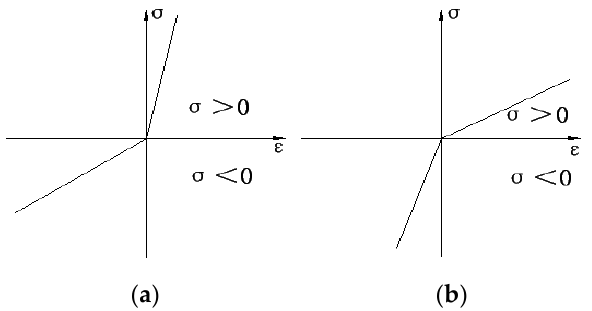
Figure 1. Bimodular materials model proposed by Ambartsumyan. ( a ) E + > E − ; ( b ) E + < E −